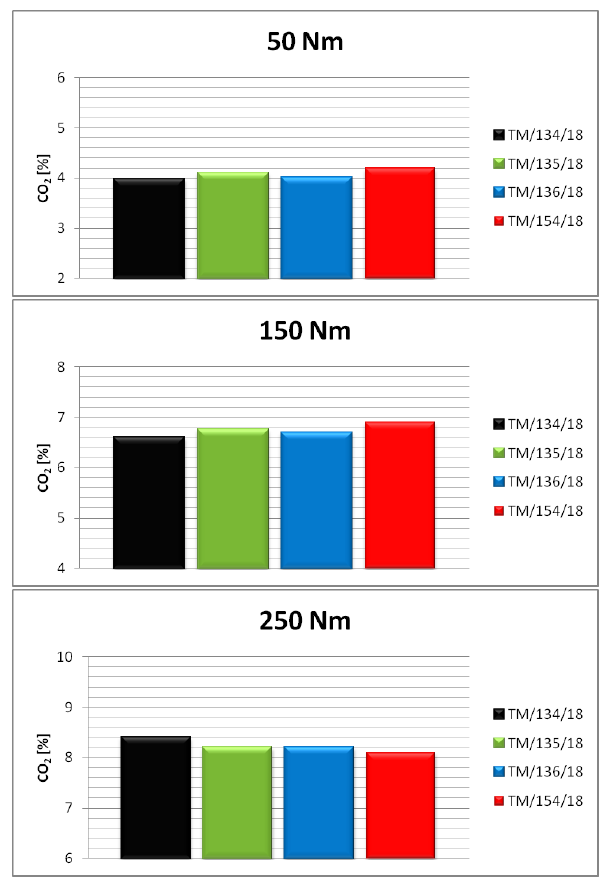
Fig. 6. CO 2 concentration in exhaust gas in selected duty points of the engine for the four tested